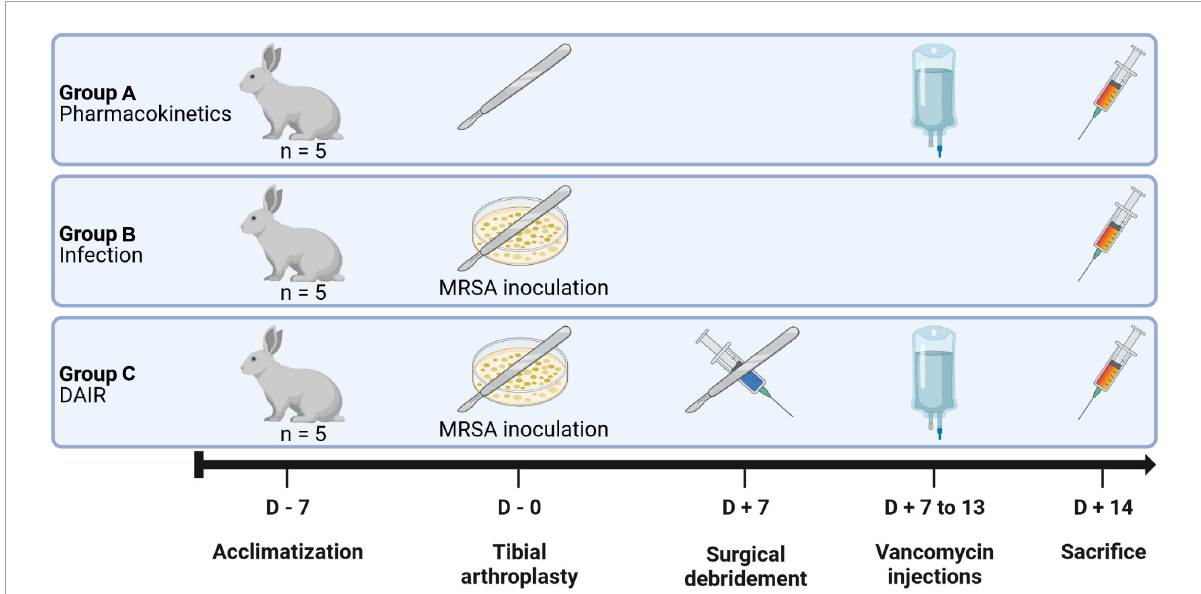
FIGURE1 Experimental design. The animals were assigned to three groups of five animals each. Group A animals were used to confirm the validity of the implants designs and to assay the pharmacokinetics of vancomycin; Group B animals were used to confirm the adequacy of the bacterial inoculum; Group C animals were infected and treated with a surgical debridement followed by the intra-articular injection of Tris-HCl buffer and a 1 week course of IV